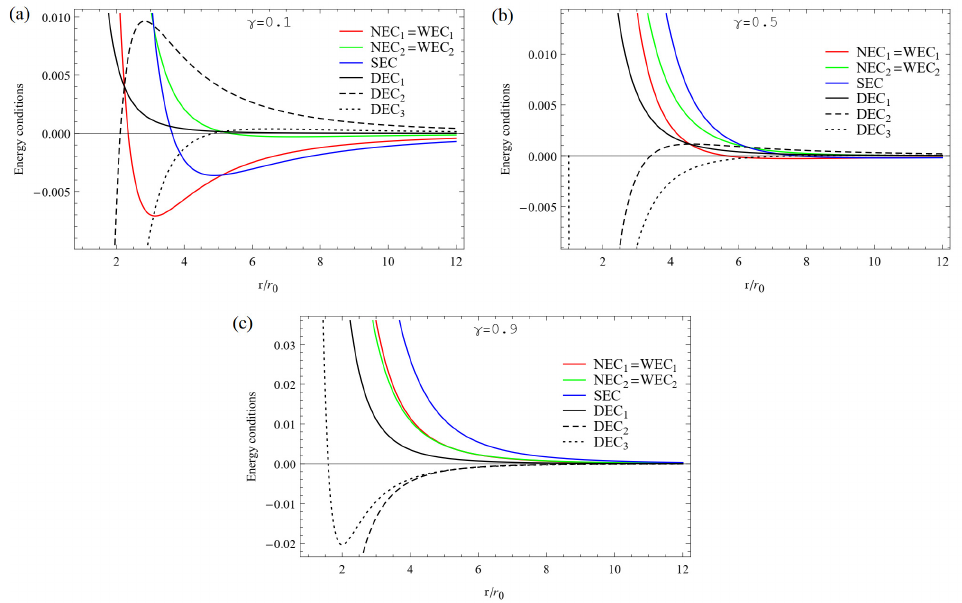
Figure 1. The energy conditions of the HKLWH as γ = 0.1 (( a ), top left hand), γ = 0.5 (( b ), top right hand), and γ = 0.9 (( c ),